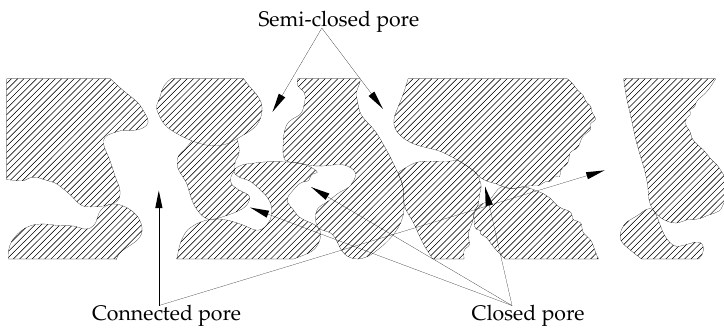
Figure 10. Pervious concrete pore types.